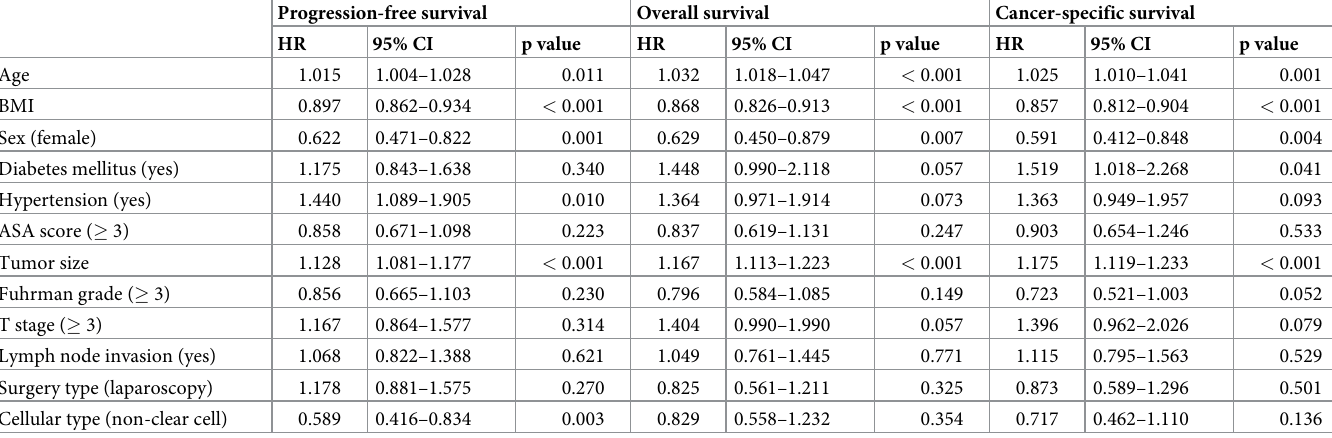
Table 2. Multivariate analysis using the Cox proportional hazard model of possible predictors of progression-free, cancer-specific, and overall survival after radical nephrectomy in patients with large ( (cid:21) 7 cm) non-metastatic renal cell carcinoma. Progression-free survival Overall survival